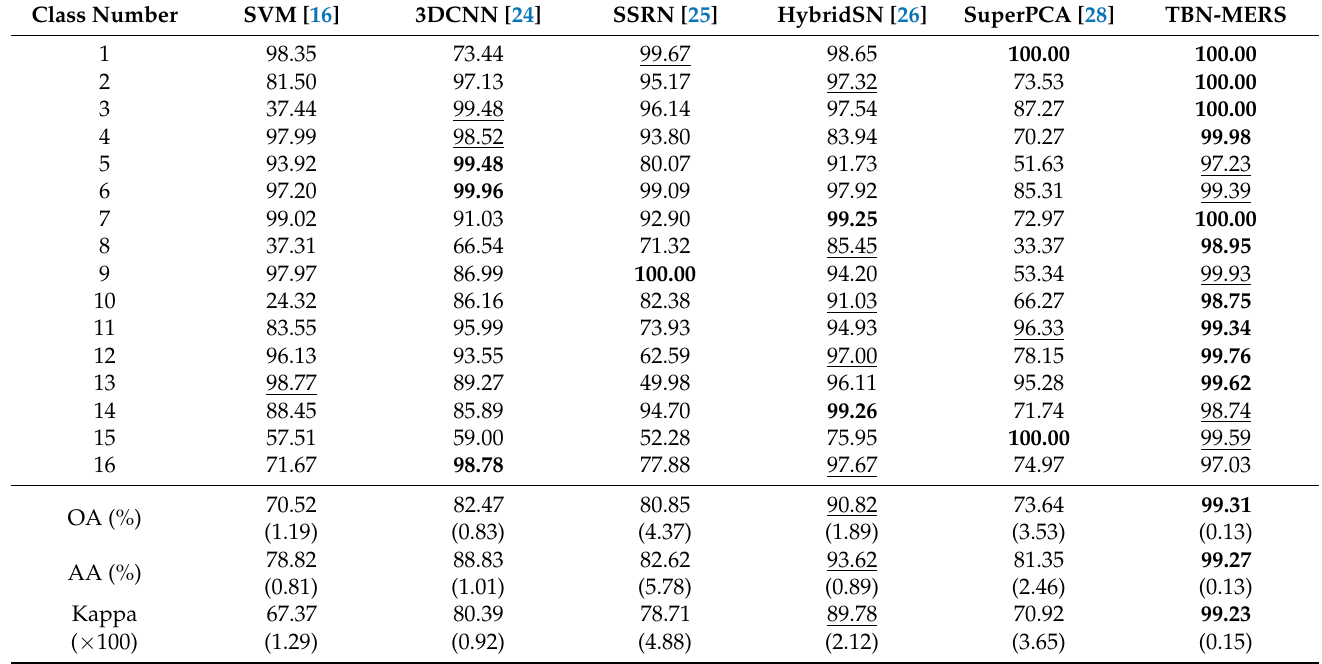
Table 12. Classification results of different methods on SA with 5 samples per